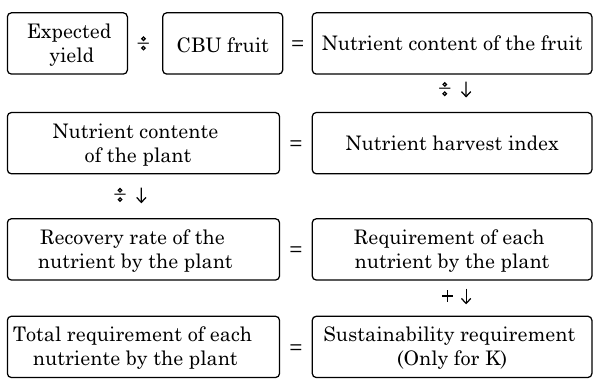
Figure 1. Flowchart used by generic Ferticalc-melon to estimate nutrient application for